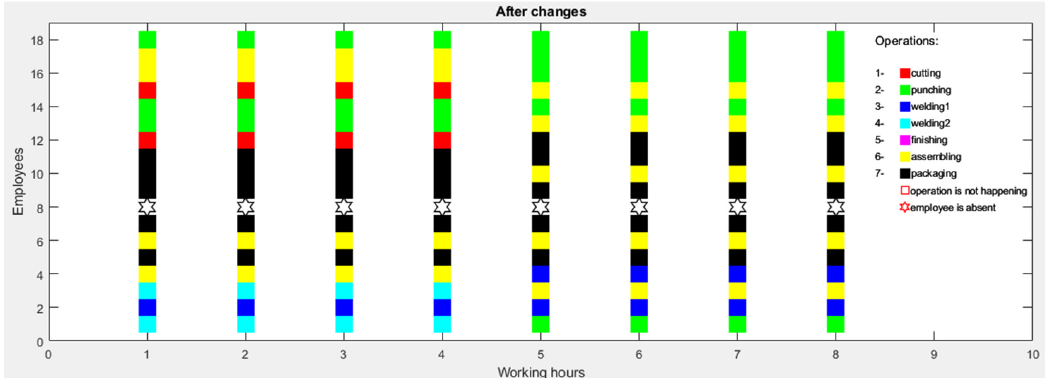
Figure 13. Data after changes, 3rd case.